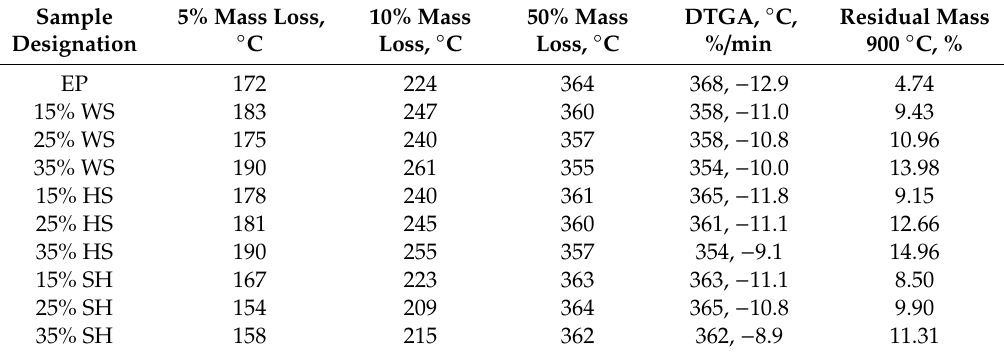
Table 2. TG and DTG data of epoxy resin (EP) and composites investigated in an inert